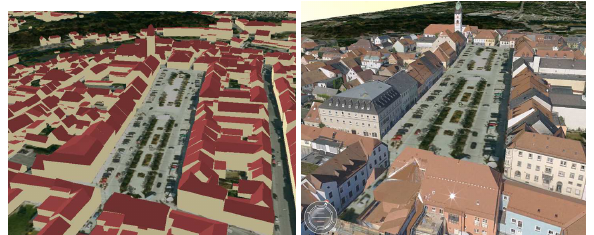
Figure 13. 3D Building Model with standardized roofs (left) and textures